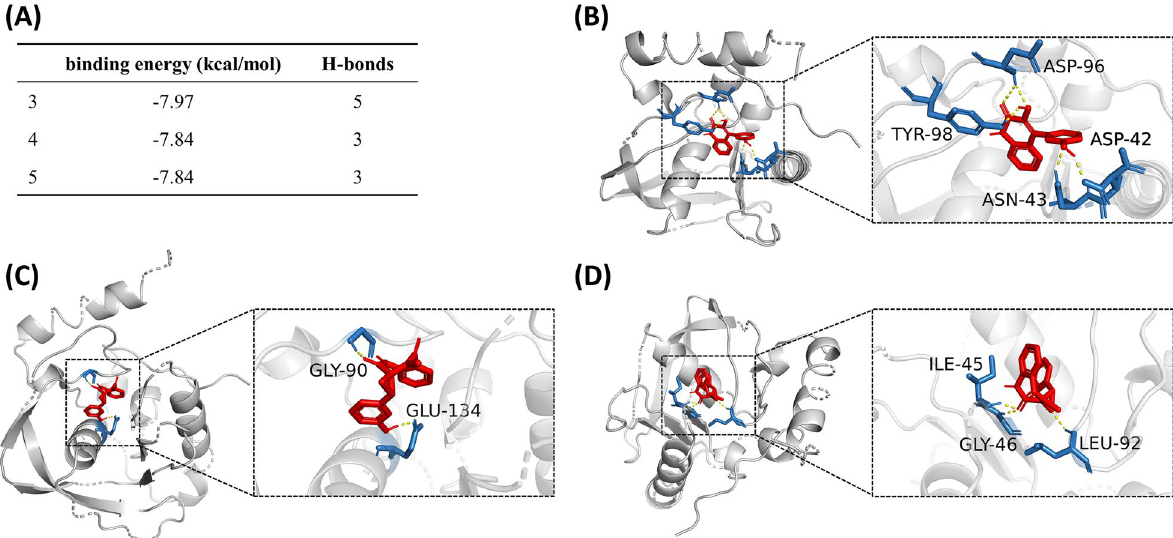
Fig. 4 Molecular docking of compounds 3 , 4 and 5 on the PDF of V . cholerae . A The binding energy and number of H-bonds of the three compounds on the PDF of V . cholerae . B – D Images showing the binding pockets of the docking between compounds 3 ( B ), 4 ( C ) and 5 ( D ) and the PDF of V . cholerae